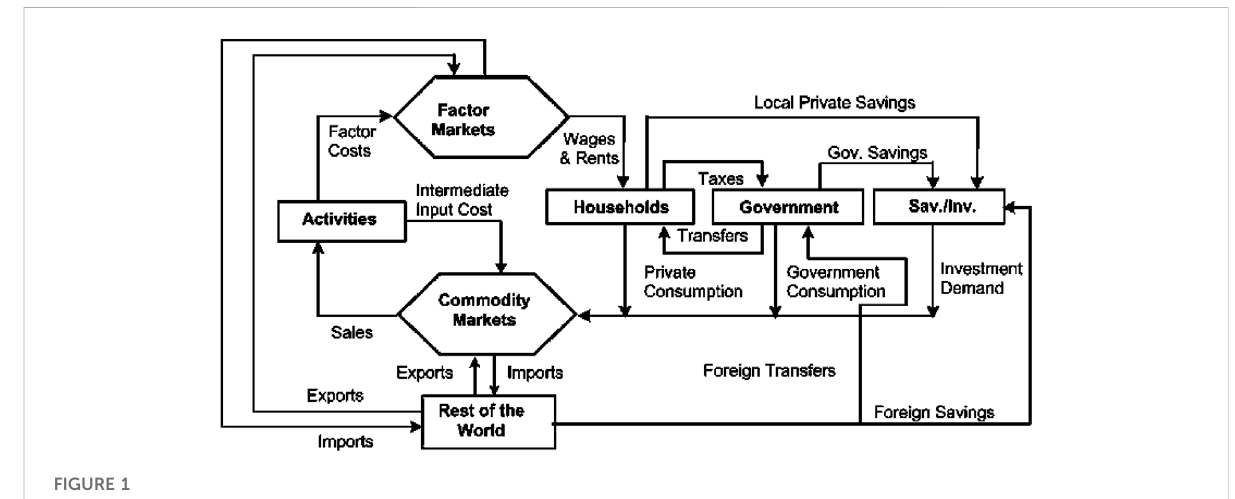
FIGURE 1 Skeleton of proposed CGE